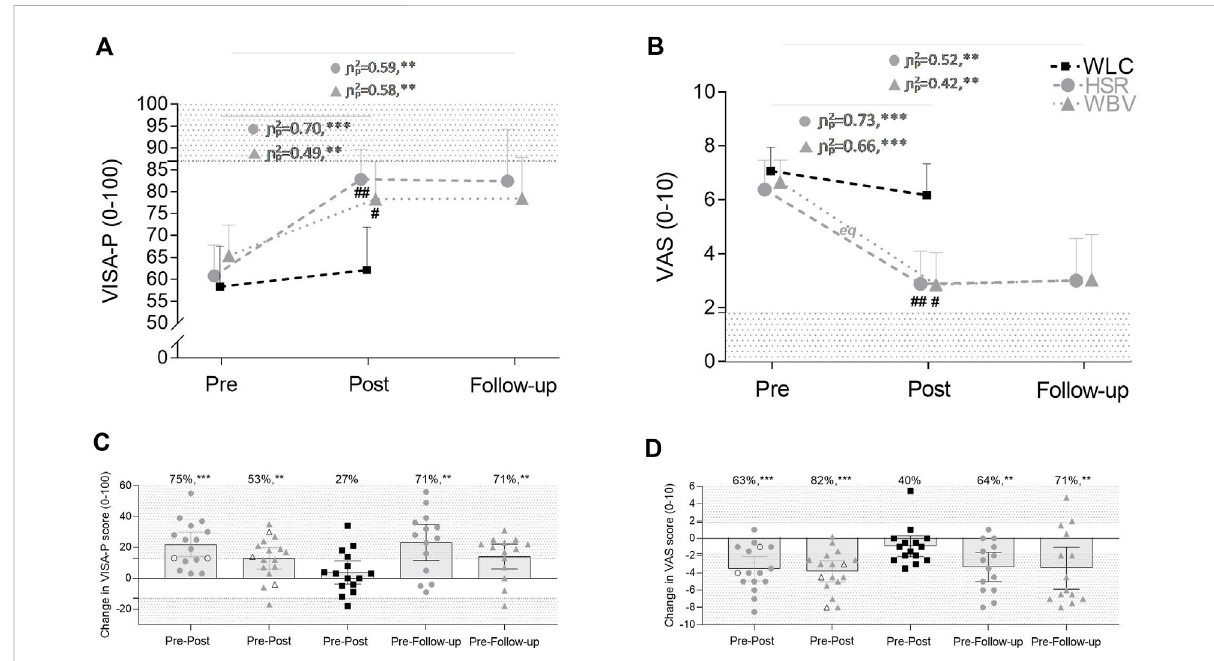
FIGURE 3 VISA-P and VAS scores at baseline, after 12 weeks of heavy slow resistance (HSR) training, whole body vibration (WBV) or waitlist control (WLC) and 6 months post-treatment phase (A,B) and scatter plots of changes in VISA-P scores (C) and VAS scores (D) . The ranges for minimal clinically relevant effects wereset at± 13 pts for VISA-P (Hernandez-Sanchez et al., 2014)and ±1.8 pts for VAS (Todd and Funk, 1996)scores, with the shaded area representing improvement and deterioration, respectively. In (C , D) , the individual improvements and the percentage of patients achieving a clinically relevant improvement are demonstrated for the HSR, the WBV and the WLC groups. Empty symbols (C , D) refer to dropouts after the intervention period. Values are mean ±95% con fi dence limits. # , p < 0.05, ## , p < 0.01, signi fi cantly different to WLC; eq , equivalence between WBV and HSR protocols was established from pre-test to post-test. Further, each subgroup was analyzed independently (paired sample t -test); **, p < 0.01, ***, p < 0.001 within